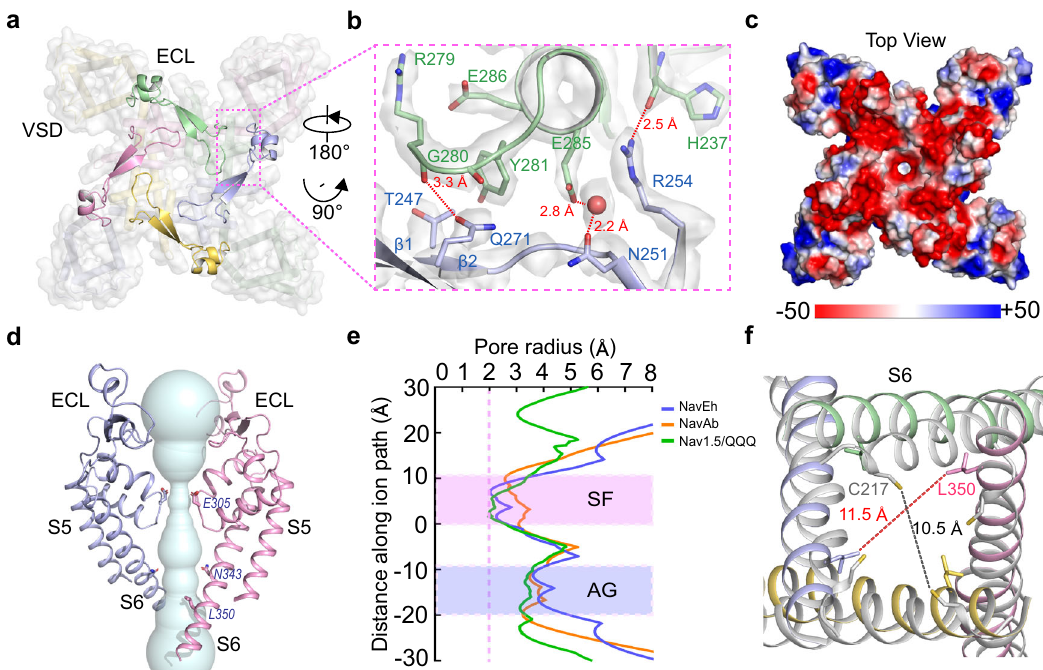
Fig. 2 The unique ECL and open gate of Na V Eh. a The ECLs of Na V Eh form external vestibule. Cartoon representation of the ECLs viewed from extracellular side. The transmembrane region shown in half-transparent surface. Pink dashed square indicates area shown in panel b . b A close-up view of interactions between the ECLs. The side-chains of key interacting residues are depicted in sticks. The red sphere represents a solvent molecule. The EM-density map is contoured at 5 σ . c Electrostatic potential of Na V Eh colored from − 50 to 50 kT (red to blue). d Ion path of Na V Eh calculated by HOLE. Residues at the constriction sites of selectivity fi lter (SF) and activation gate (AG) shown side-chains in sticks. Only two opposing subunits shown for clarity. e Pore radii of Na V Eh from panel d . As a comparison, pore radii of open Na V Ab (PDB code: 5VB8, brown) and open Na V 1.5 (PDB code: 7FBS, green) are presented. f Gate superposition of Na V Eh and open Na V Ab (PDB code: 5VB8, colored in